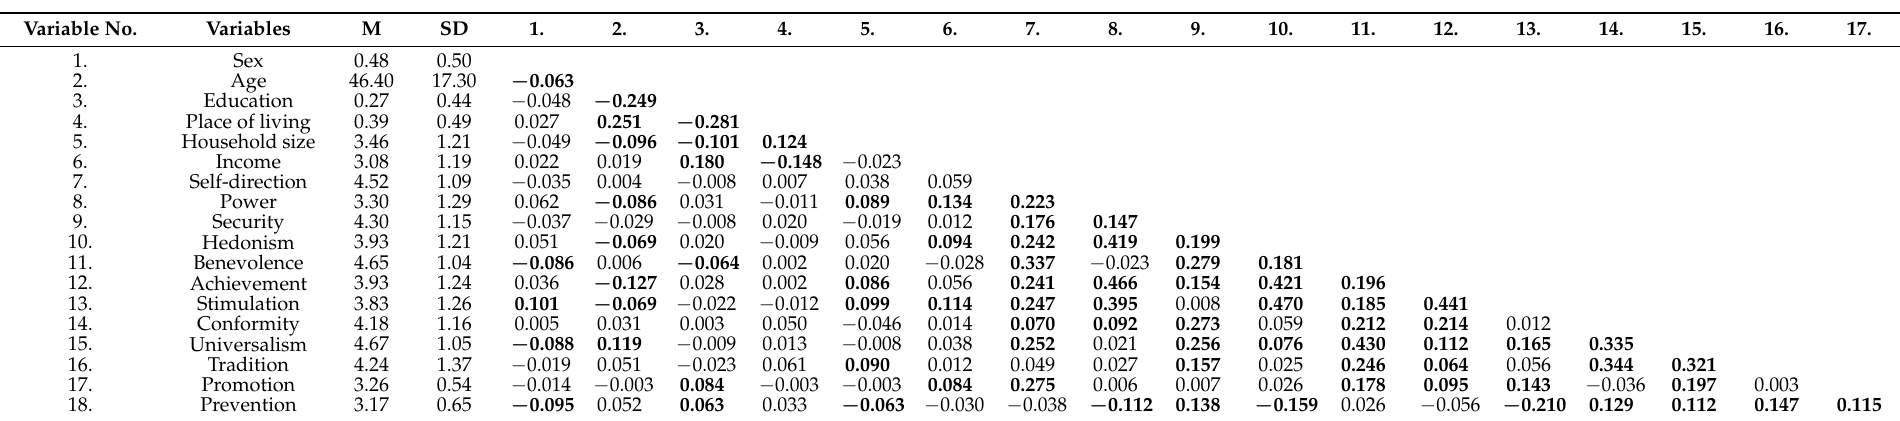
Table 8. Correlation matrix for independent variables used in my regression